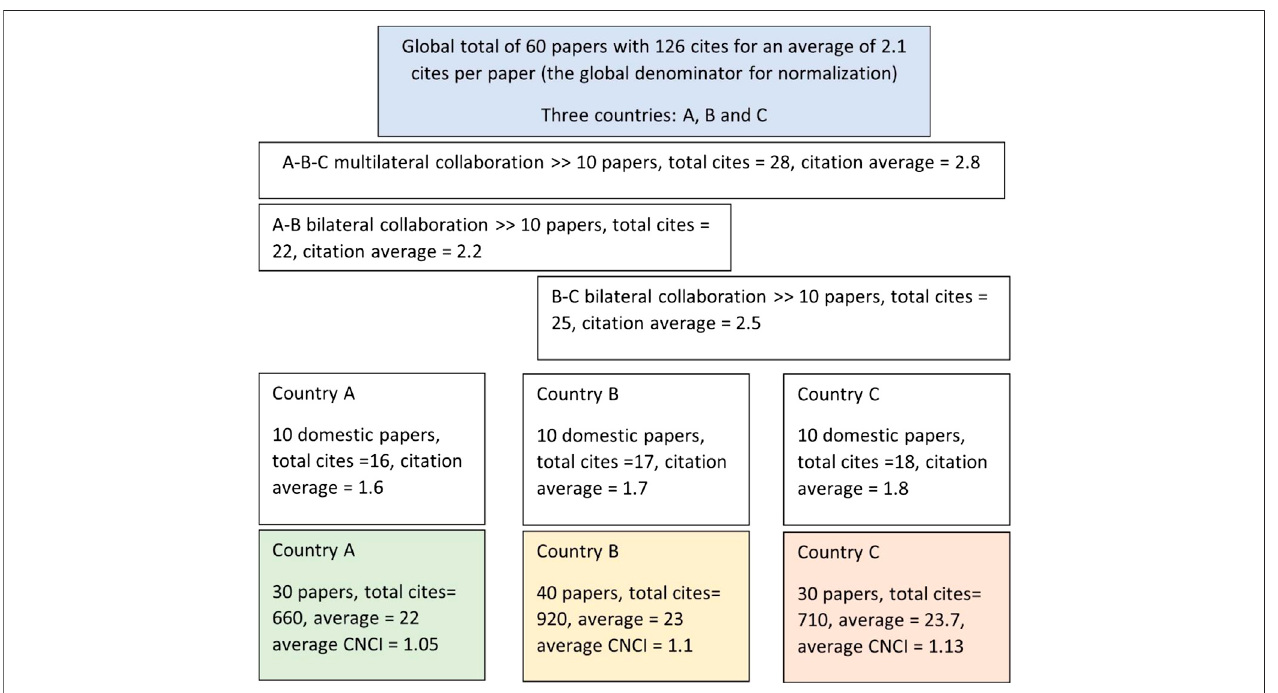
Figure 8 | For a hypothetical universe of three small countries, with some shared and some purely domestic papers, it is evident that the global average citation count may be less than that of any one contributor. This is because domestic papers are on average less frequently cited than internationally collaborative work and the global total includes all three domestic pools whereas each country only hosts its